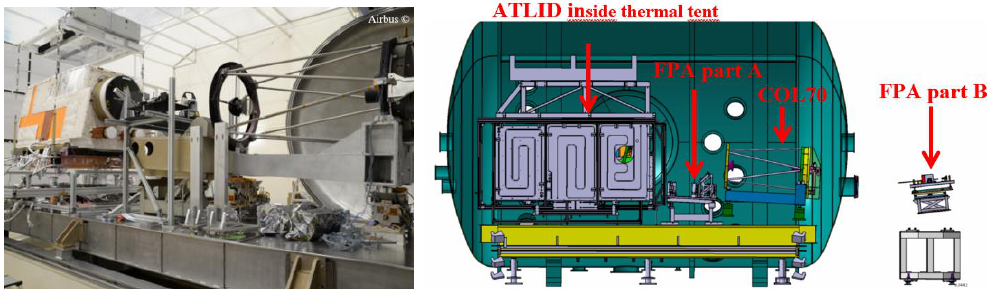
Figure 6. ATLID test configuration in vacuum chamber, with FPA (Focal Plane Assemblies) parts A&B and collimator COL70. Reproduced with permission of Airbus © .